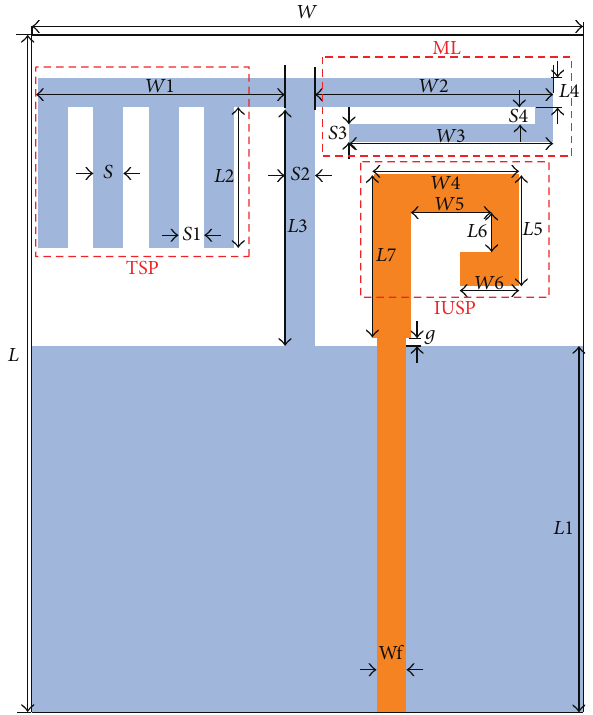
Figure 1: Configuration of the proposed triband antenna.